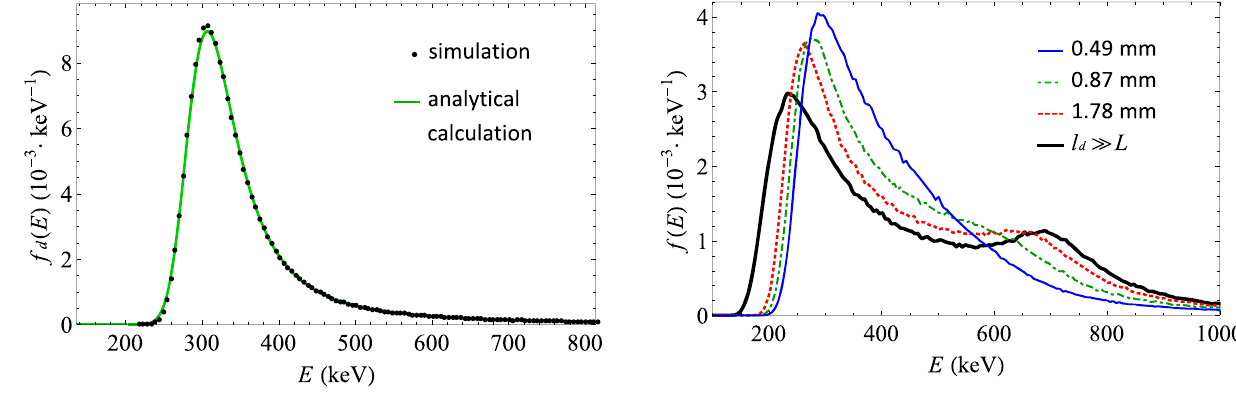
Fig. 1 Ionization loss spectrum of 150 GeV/c π − mesons in a disori- ented 1 mm silicon target